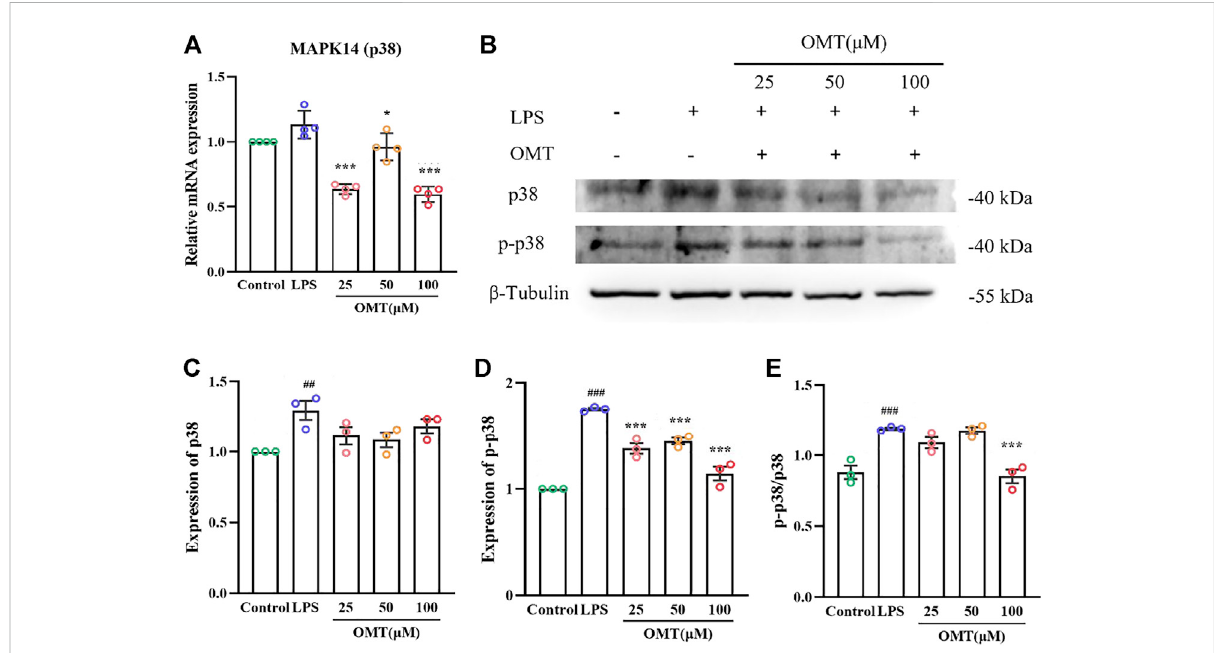
FIGURE 12 Effects of OM on the mRNA expression and protein phosphorylation expression of LPS-induced RAW264.7 cell in fl ammation model. (A) The mRNA expression of p38mRNA, (B – E) protein level and phosphorylation level of p38. Values represent average ± S.D. Signilicani differences among different groups are indicated as ## p < 0.01, ### p < 0.001 vs. control; * p < 0.05, ** p < 0.01, *** p < 0.001 vs. LPS